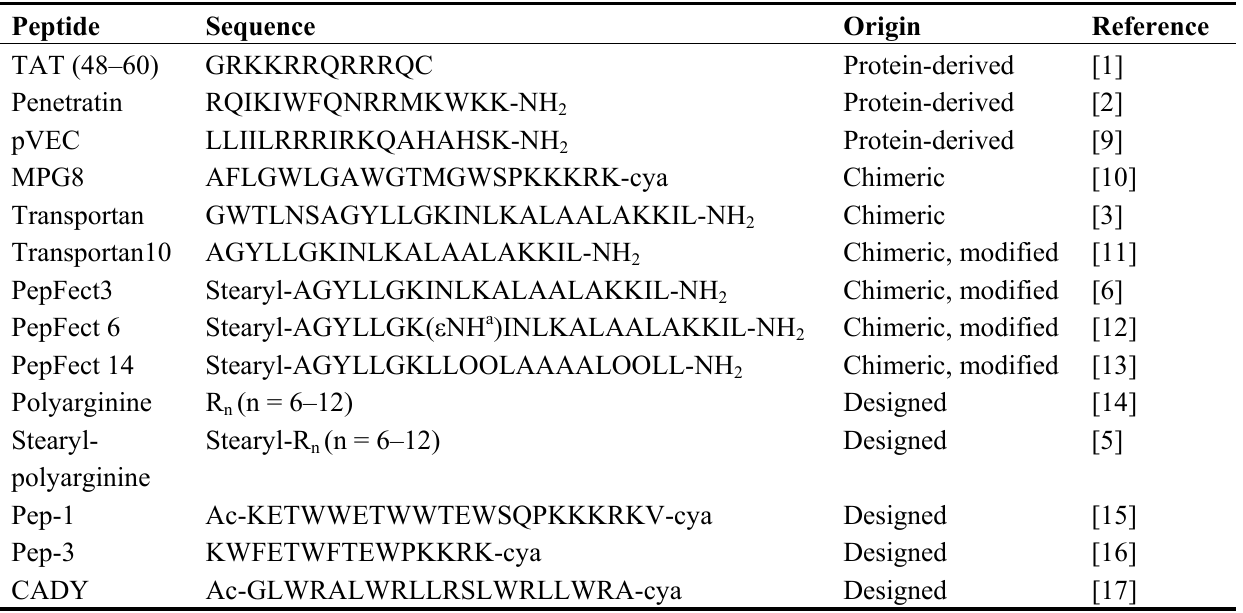
Table 1. Examples of